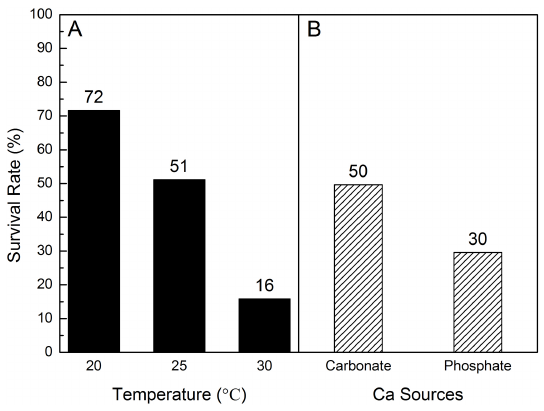
Figure 2. Snail survival rate: (a) at different temperatures; (b) with different calcium